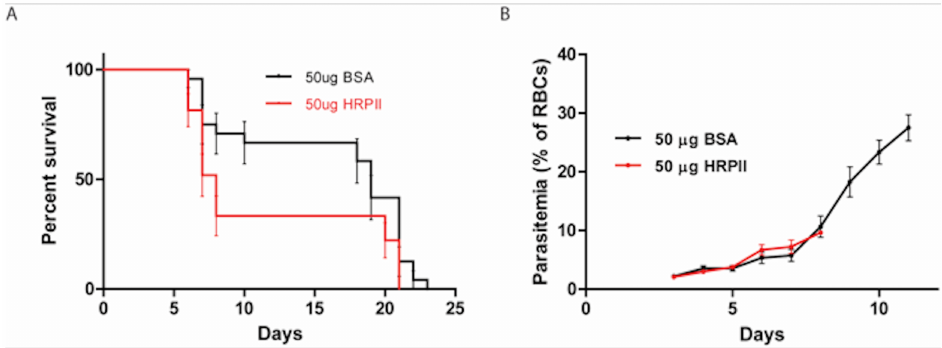
Fig 3. HRPII reduces survival time in an experimental cerebralmalaria model. ( A ) Survival curves of 4-week old female mice infused with 50 μ g of BSA or HRPII prior to infectionwith P . berghei ANKA (10 5 parasites). Shownare the means for n = 24 to 27 mice pooledfrom four independentexperiments. Curves are significantly different, p = 0.03, by the log-rank(Mantel-Cox) test. Mean time to death for HRPII = 11.5 days and for BSA = 16 days, p = 0.018, by two tailed t-test. ( B ) Mice displayingcerebral malaria-like symptoms died at low parasitemia by day 10, yet parasitemias between HRPII-infused mice and controls were closely matched on each day. Representative data from one of three experiments shown in panel A, 10 mice per